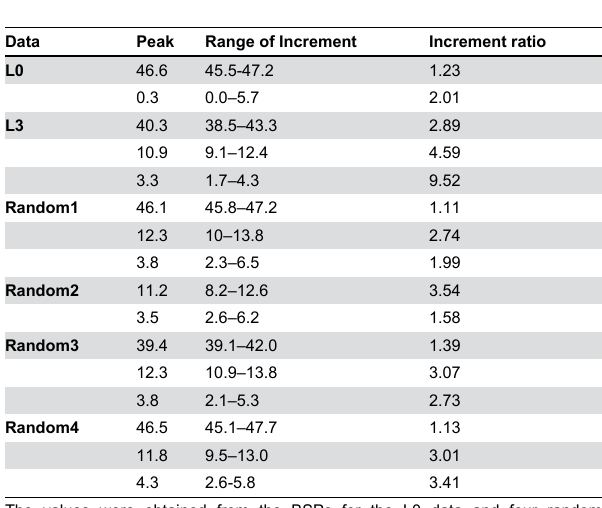
Table 2. Peaks of rate of population size change through